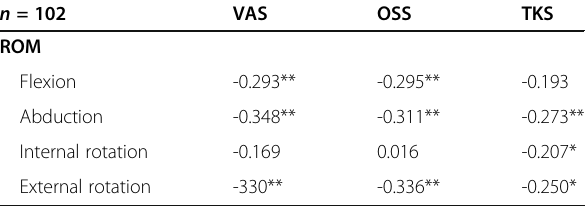
Table 4 Correlation between ROM with VAS, OSS, and TKS n = 102 VAS OSS TKS ROM